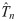
Results of the UCM analysis in simulation experiments.The UCM and ORT components for the uncoordinated input (a) and those for the coordinated input (c). The blue and red bars denote the component variance for the measured muscle tensions T
i and that for the normalized muscle tensions T^n, respectively. The index of synergy for the uncoordinated input (b) and that for the coordinated input (d). The red line indicates the value of no coordination (where the UCM component is equal to the ORT component). The asterisk indicates significant difference (P < 0.05) between the UCM and ORT components ((a) and (c)) and from the red line ((b) and (d)), and n.s. indicates a non-significant difference. Specific values are listed in S2 Table.